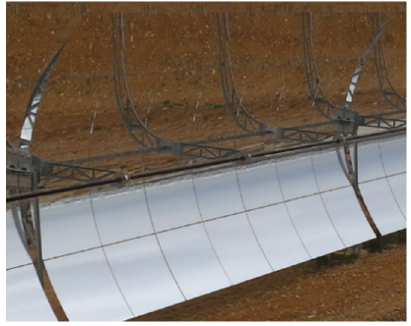
Figure 2. Solar collector assembly (SCA).